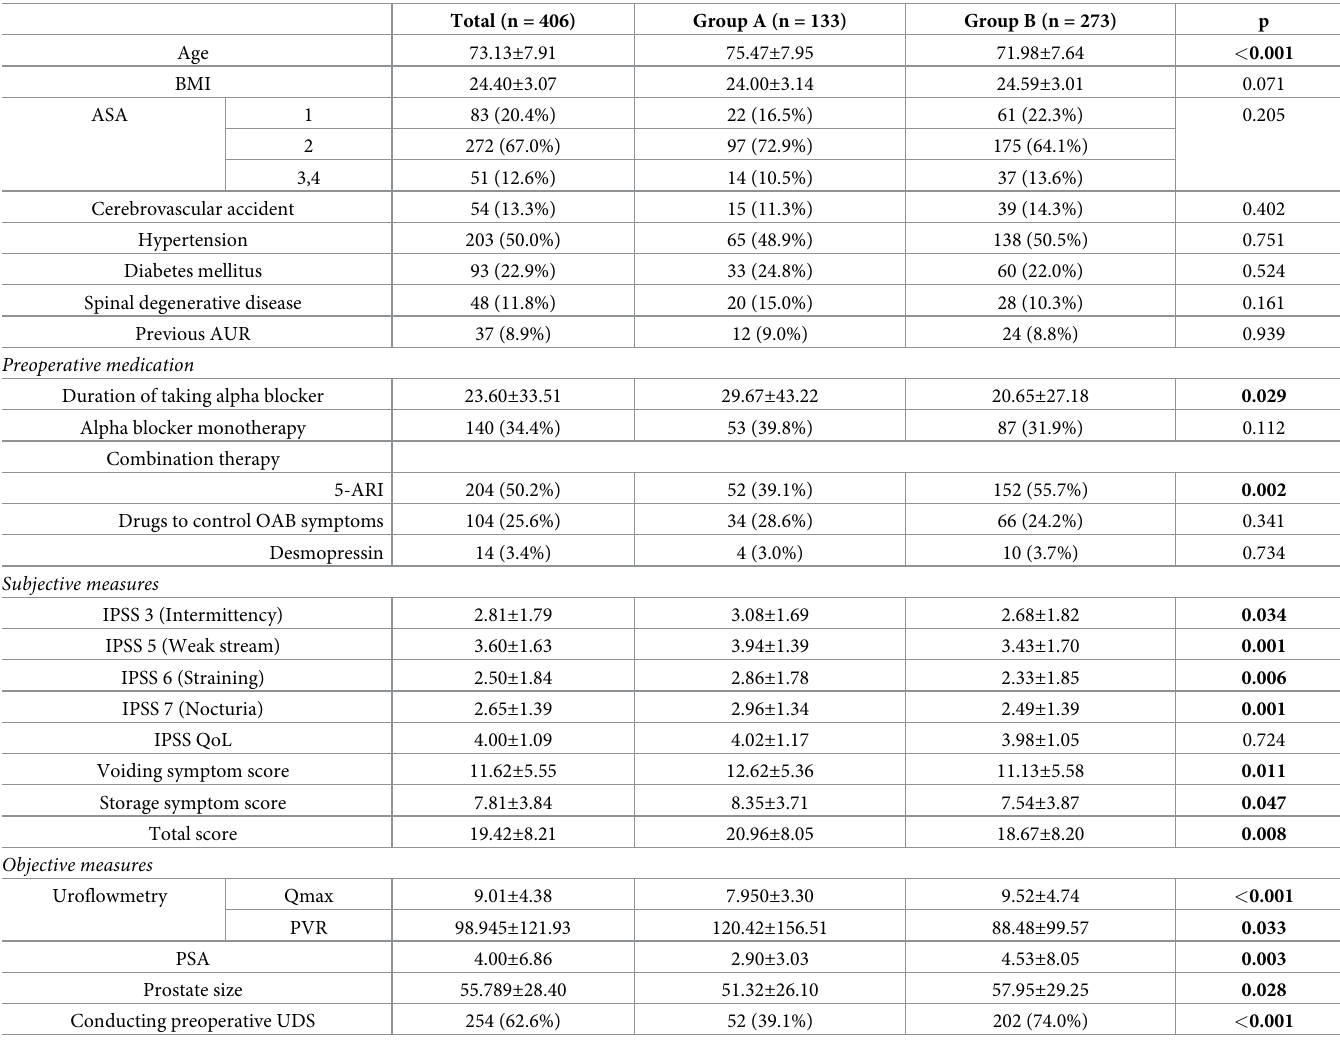
Table 1. Baseline